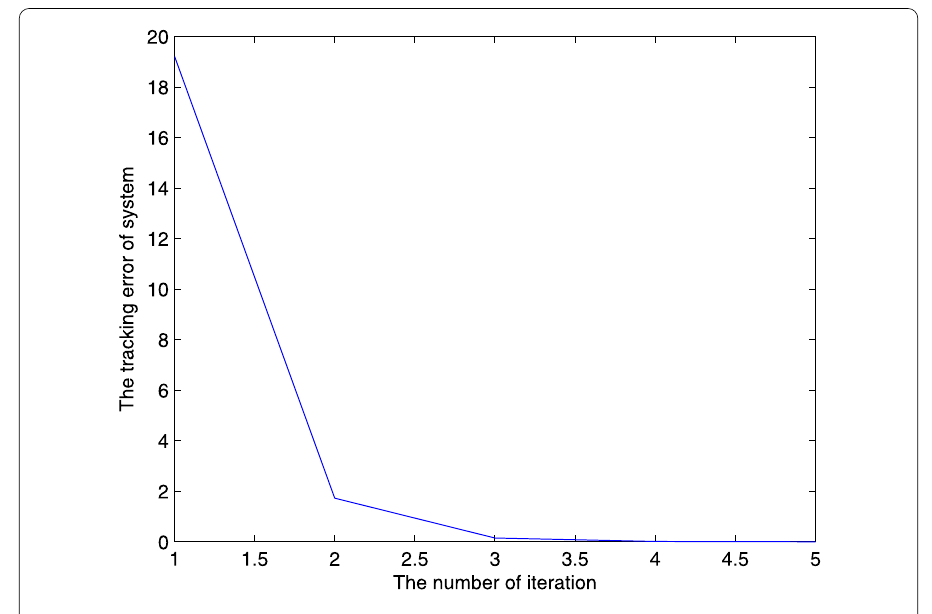
Figure 7 Number of iterations and tracking error.